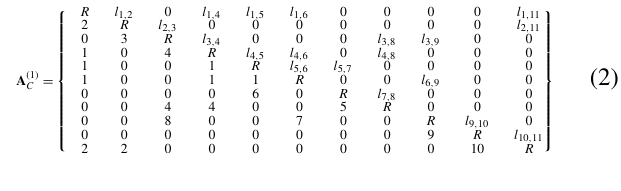
The adjacency matrix is the matrix of the adjacent relations between vertices, representing the relationship between kine- matic pairs and links. The element value of the non-zero is converted to ”1”. Diagonal elements are omitted. The